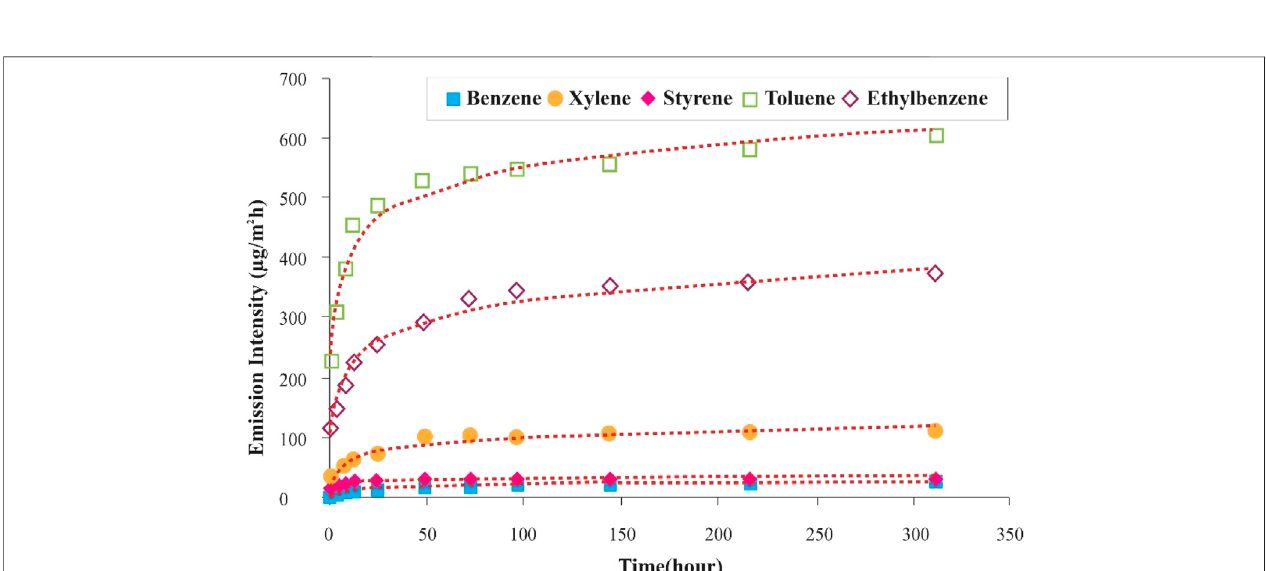
FIGURE 10 | Cumulative emission of VOCs from